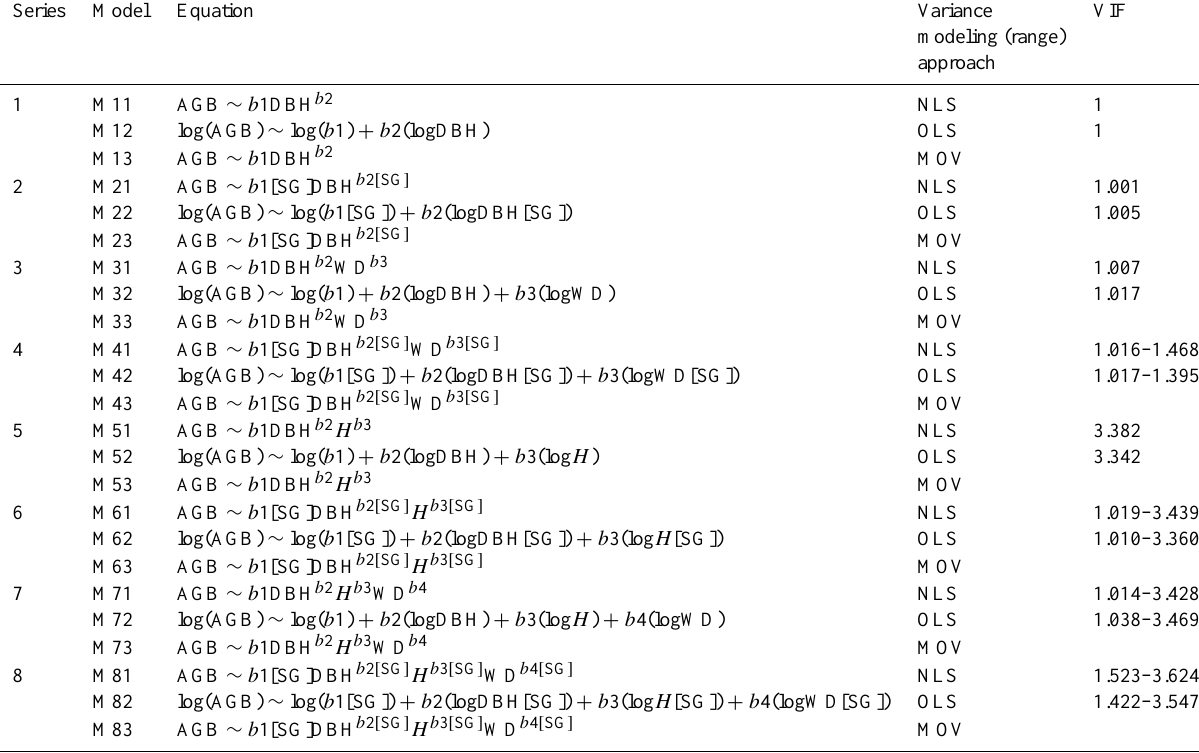
Table 2. Tested equations for estimating aboveground tree biomass (AGB) in a terra firme forest near Manaus, Amazonas, Brazil. Series Model Equation Variance VIF